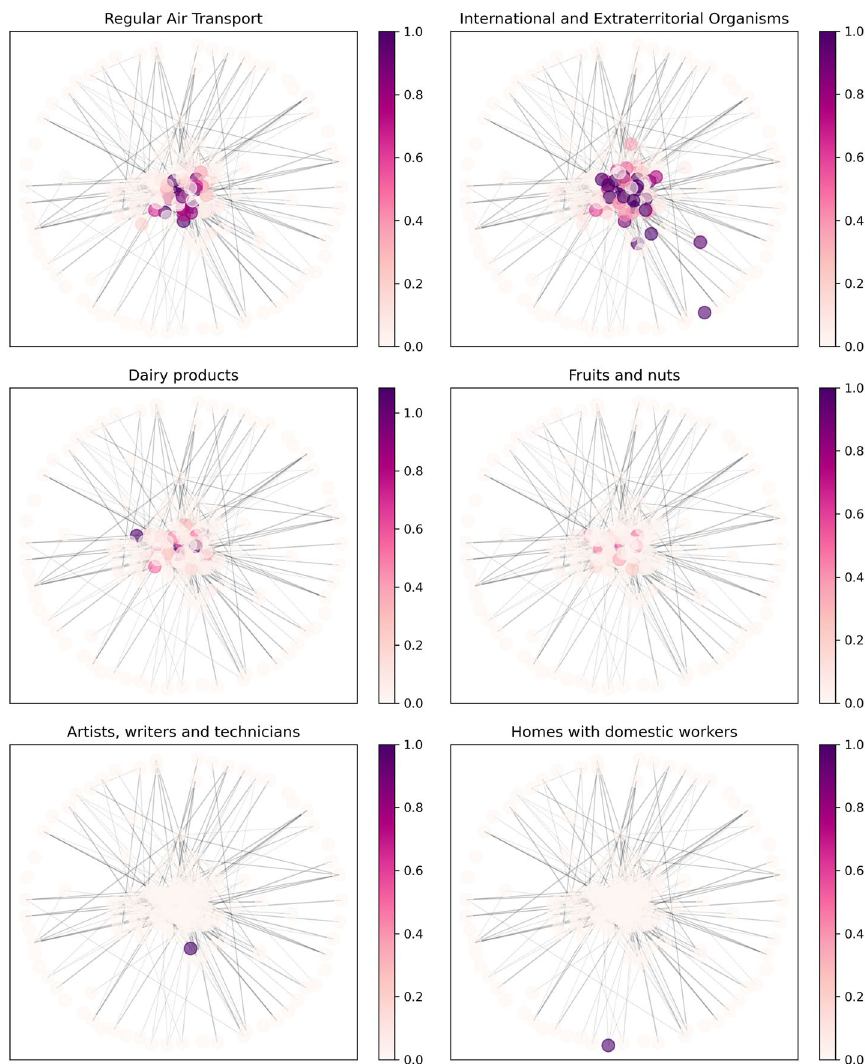
Fig. 1 Example of the diffusion of the effect of a shock in the Mexican economy. Color bar corresponds to magnitude of effect. Colors are normalized in each case to the maximum of the effect. The darkest color corresponds to 1 in the color bar and to the largest effect in each case. The network visualization corresponds to a spring layout with 200 iterations. This figure was generated by authors based on INEGI data using Python 3.8 and Python libraries scipy, numpy, networkX, and matplotlib. Source: Visualizations made by authors based on